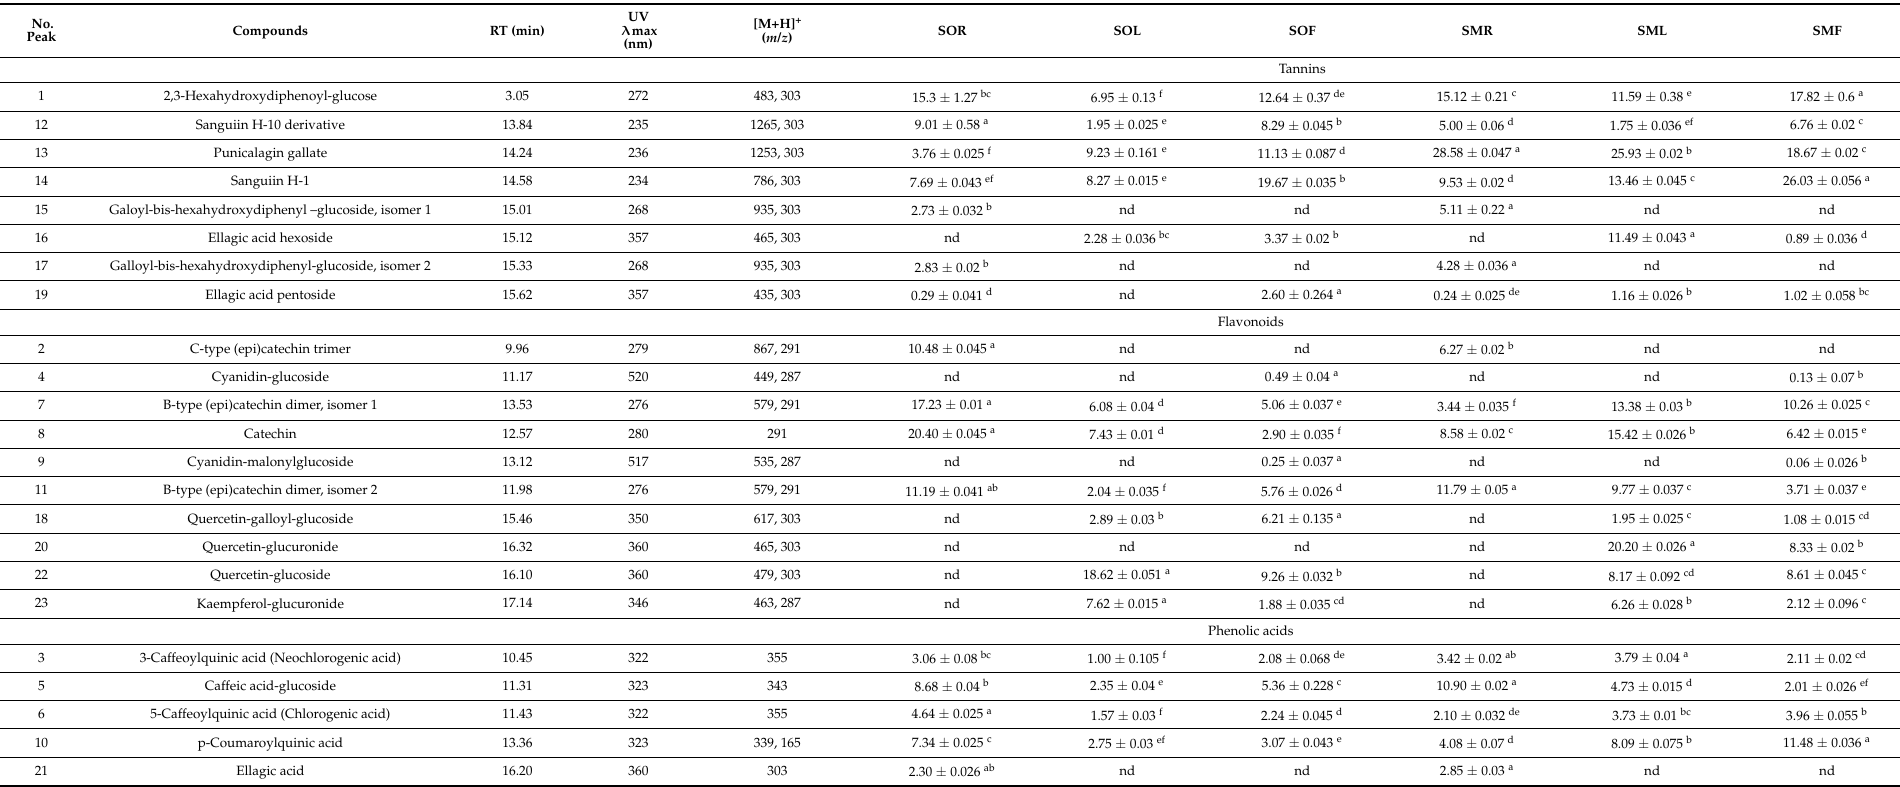
Table 1. HPLC–DAD-MS (ESI + ) profile of phenolic compounds (mg/g dw) in roots, leaves and flowers of S. officinalis L. and S. minor